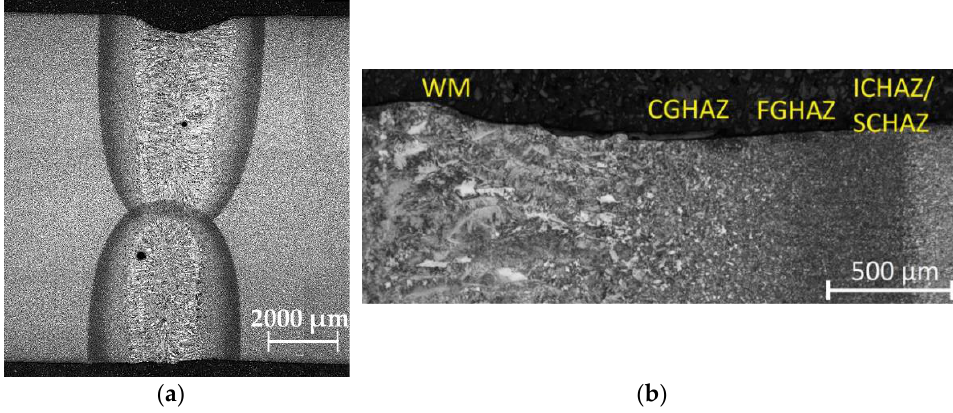
Figure 2. Macrostructure of ( a ) the weld cross-section and ( b ) particular zones after etching.